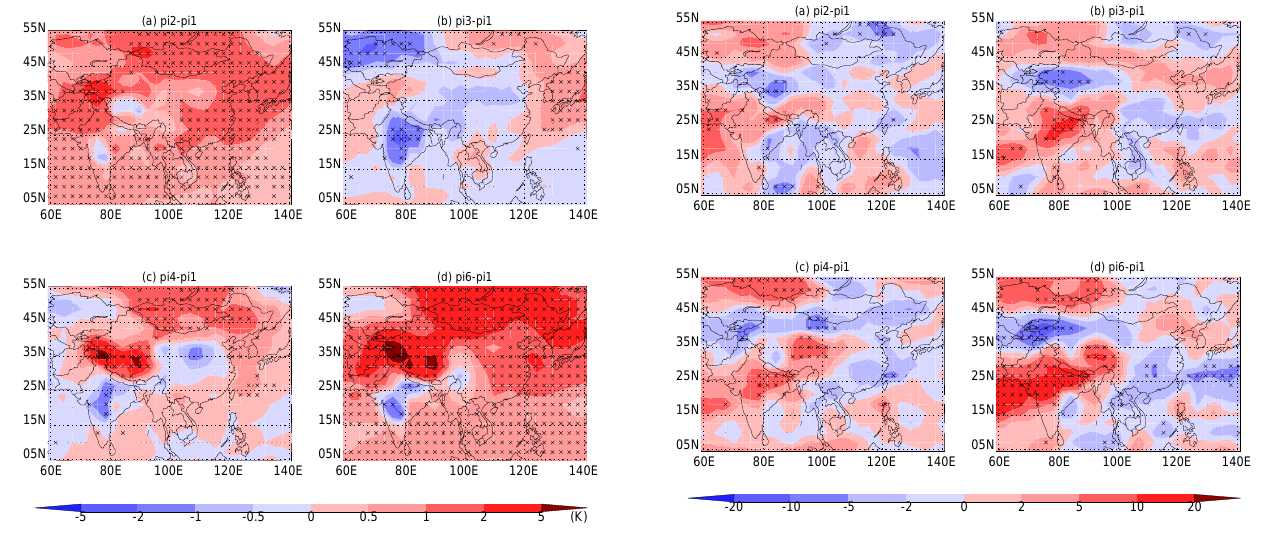
Fig. 13. Spatial distribution of surface skin temperature change av- eraged for May for pi2-pi1 ( a , induced by CO 2 increase), pi3-pi1 ( b , induced by BC+OM in atmosphere), pi4-pi1 ( c , induced by BC in snow), and pi6-pi1 ( d , induced by CO 2 increase + BC+OM in at- mosphere + BC-in-snow), respectively. (Unit: K). Regions passing the 90% significance level are highlighted by cross.